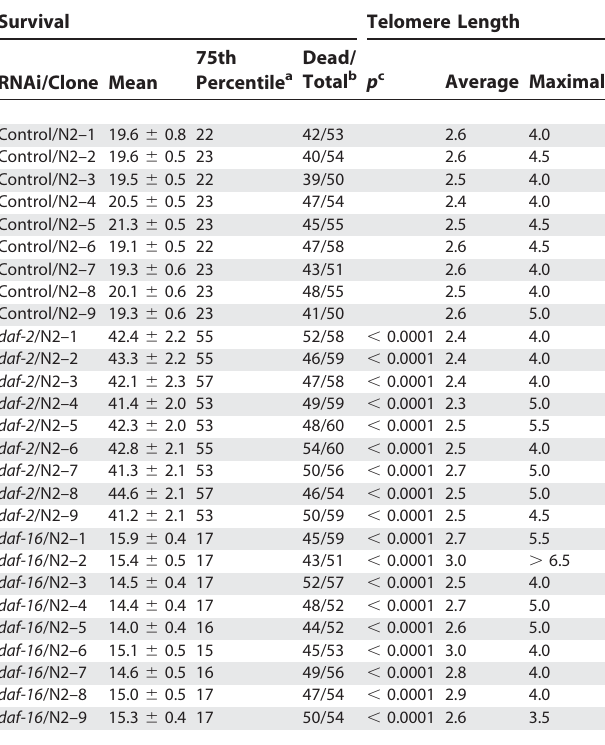
Table 2. Survival, Average and Maximal Telomere Length of Control, daf-2 (RNAi) and daf-16 (RNAi) Clones Survival Telomere Length